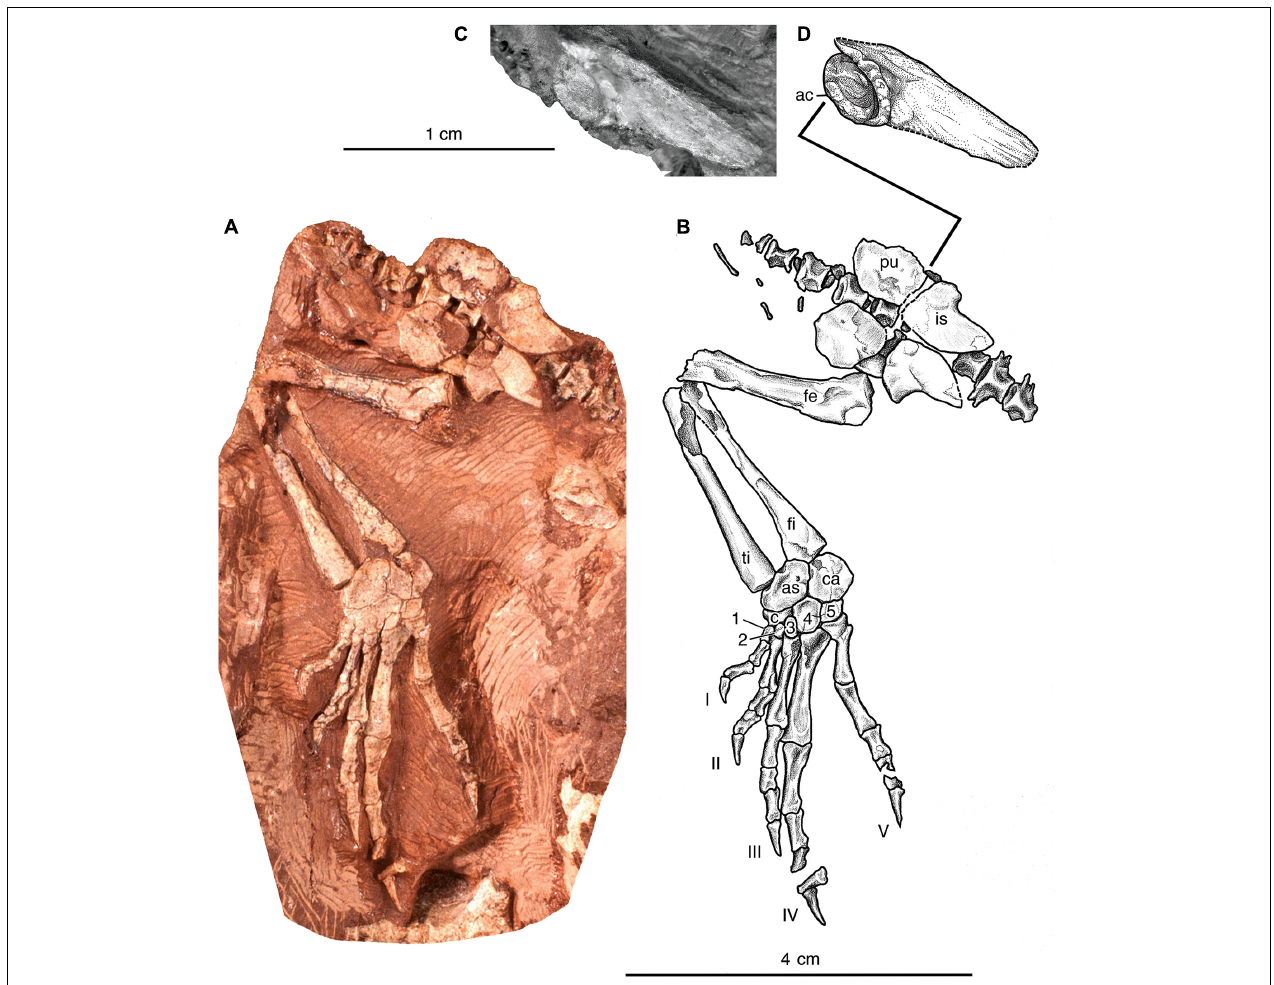
FIGURE 2 | Eudibamus cursoris , referred specimen (MNG 12895). (A) Photograph and (B) illustration of entire articulated specimen in ventral view, consisting of partial vertebral column spanning from approximately posteriormost four presacral vertebrae to the anteriormost three caudal vertebrae, pelvis, and right hindlimb. (C) Photograph and (D) illustration of partial left ilium shown isolated in lateral